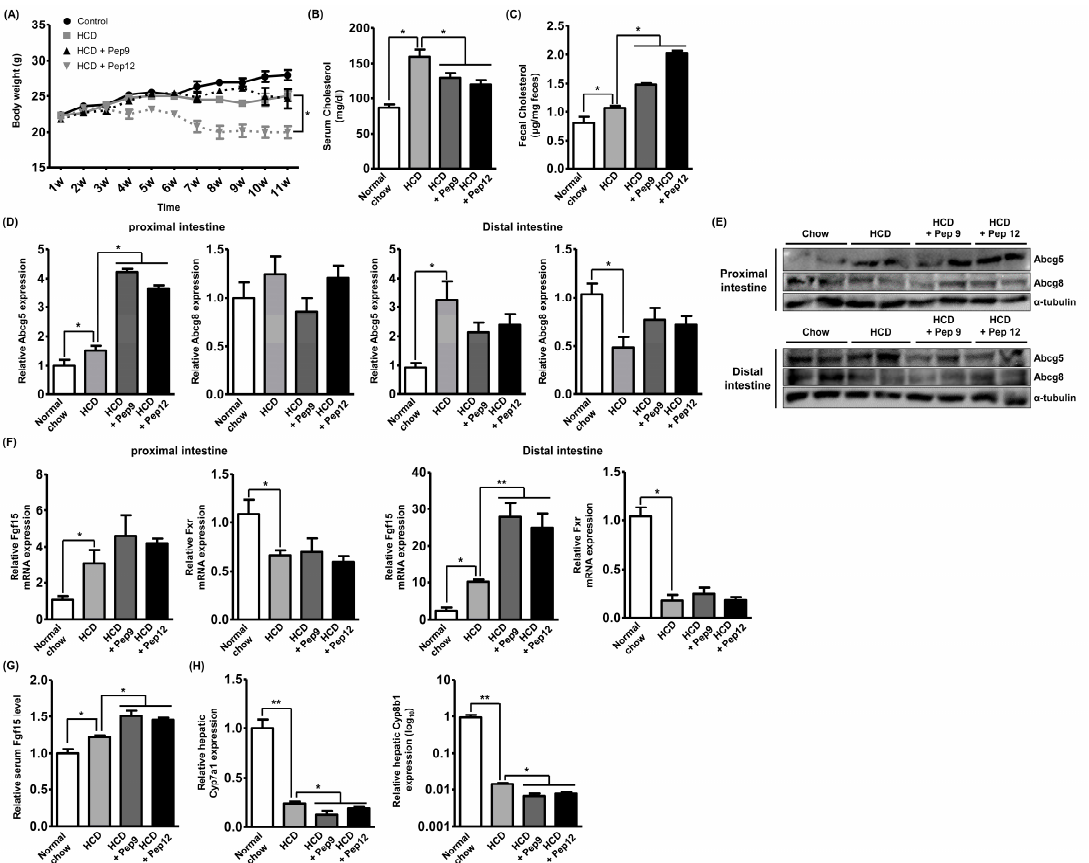
Figure 5. Oral administration of bioactive peptide regulates in vivo hyperlipidemia. ( A ) The change in body weight was traced after beginning of HCD and peptide administration. The treatment was started at 1st week and mice were sacrificed at 11th week after 6 h of fasting from last treatment. ( B ) Serum cholesterol levels from mice fed with HCD or/and peptides were assessed by cholesterol assay. ( C ) Fecal cholesterol levels from mice fed with HCD or/and peptides were assessed by cholesterol assay. ( D , E ) The mRNA and protein expression of ABCG5 and ABCG8 in proximal or distal intestine of mice fed with HCD or / and peptides were assessed by qRT-PCR or Western blot analysis. ( F ) The mRNA expression of FGF15 and FXR in proximal or distal intestine of mice fed with HCD or / and peptides was assessed by qRT-PCR. ( G ) The serum FGF15 level of mice fed with HCD or / and peptides was assessed by ELISA. ( H ) The hepatic mRNA expression of CYP7A1 and CYP8B1 of mice fed with HCD or / and peptides was assessed by qRT-PCR. * p < 0.05. ** p < 0.01.